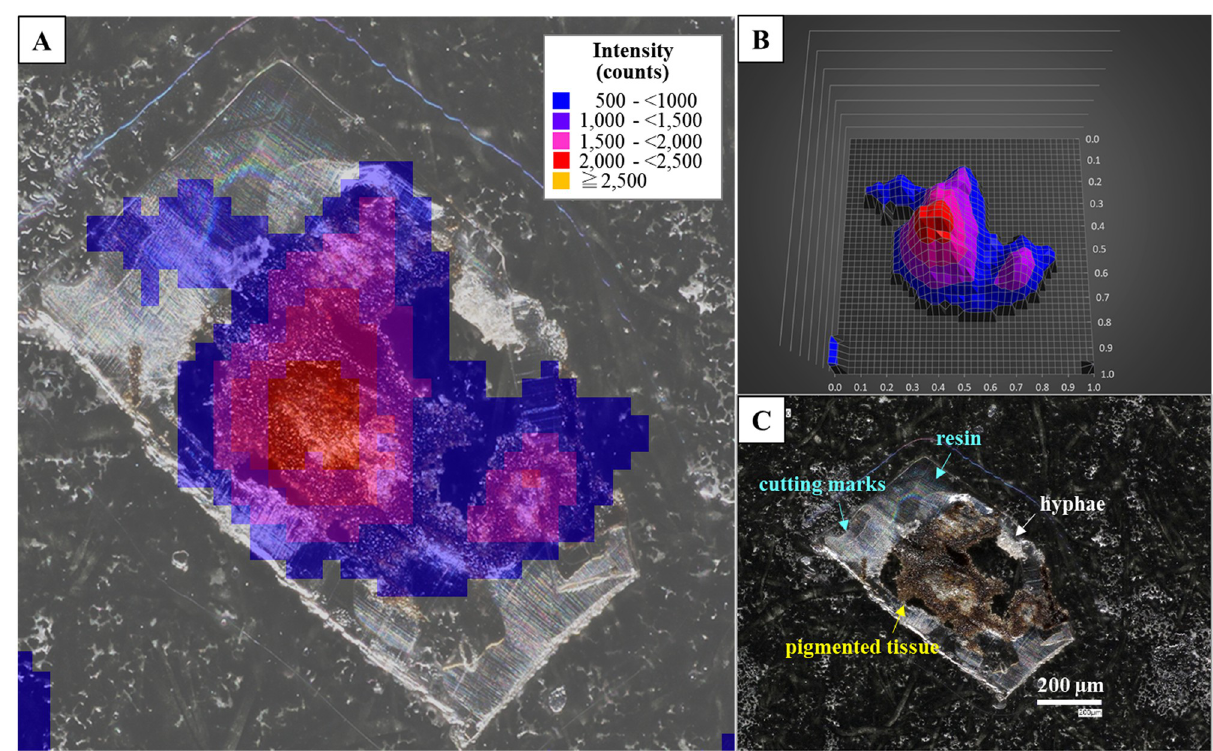
Fig 6. Radiocaesium distribution in tissue section of the FY2017PT sample with “b-5” as an example. (A) Overlapping image of the autoradiograph result and tissue section image. The background counts were deducted from all count values. Each colour indicates the range of the PSL signal intensities as shown in the legend, which also applies to (B). (B) Three-dimensional image of (A) in a 1 mm square area. (C) Image of tissue section taken with the digital microscope. The brown parts are pigmented tissue (yellow arrow), white parts are hyphae (white arrow), and transparent parts are resin (aqua arrow). Cutting marks from the glass knife appeared as a white linear pattern on the